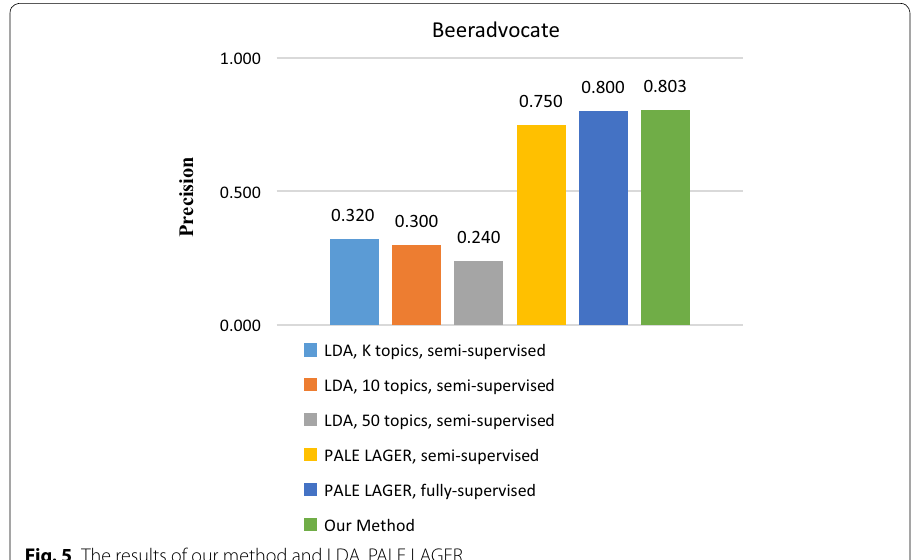
Fig. 5 The results of our method and LDA, PALE